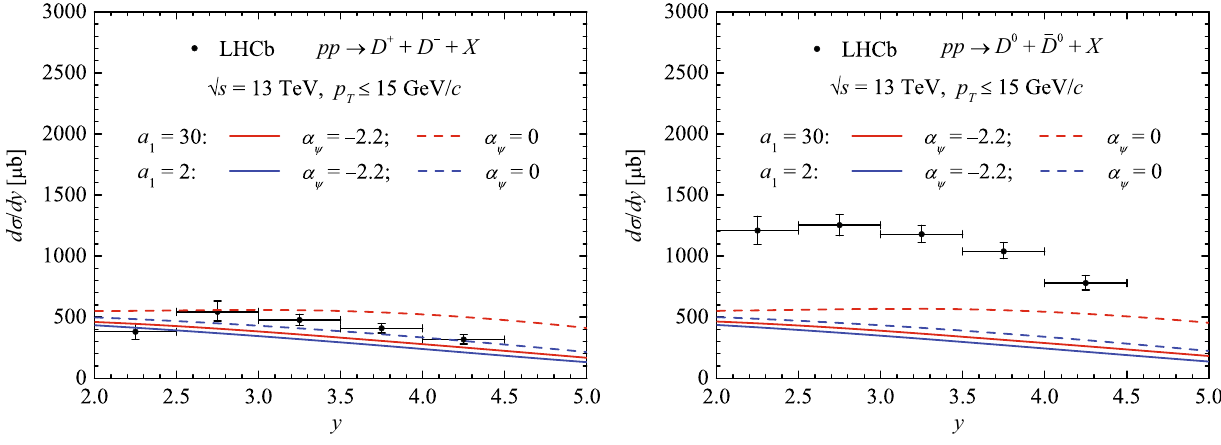
Fig. 11 Differential cross sections of charged D mesons (left) and neutral D mesons (right) in pp collisions at LHCb experiment [53]. The same notation for lines as in Fig.